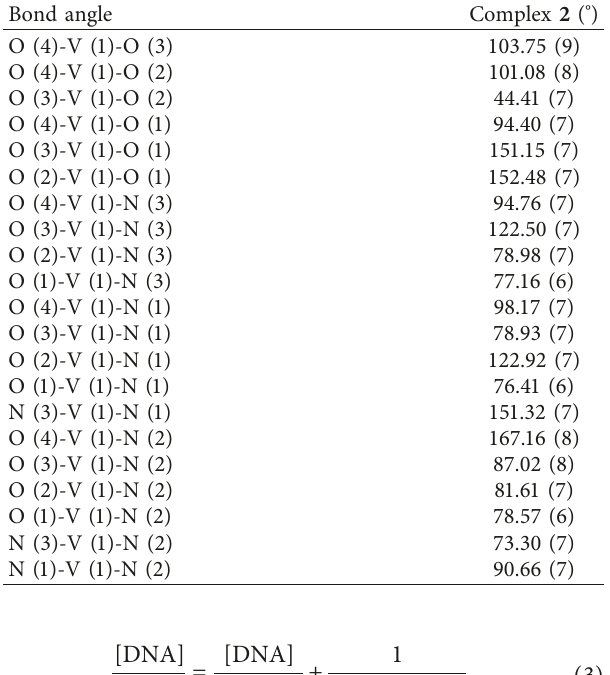
Table 3: Bond angles of complex 2